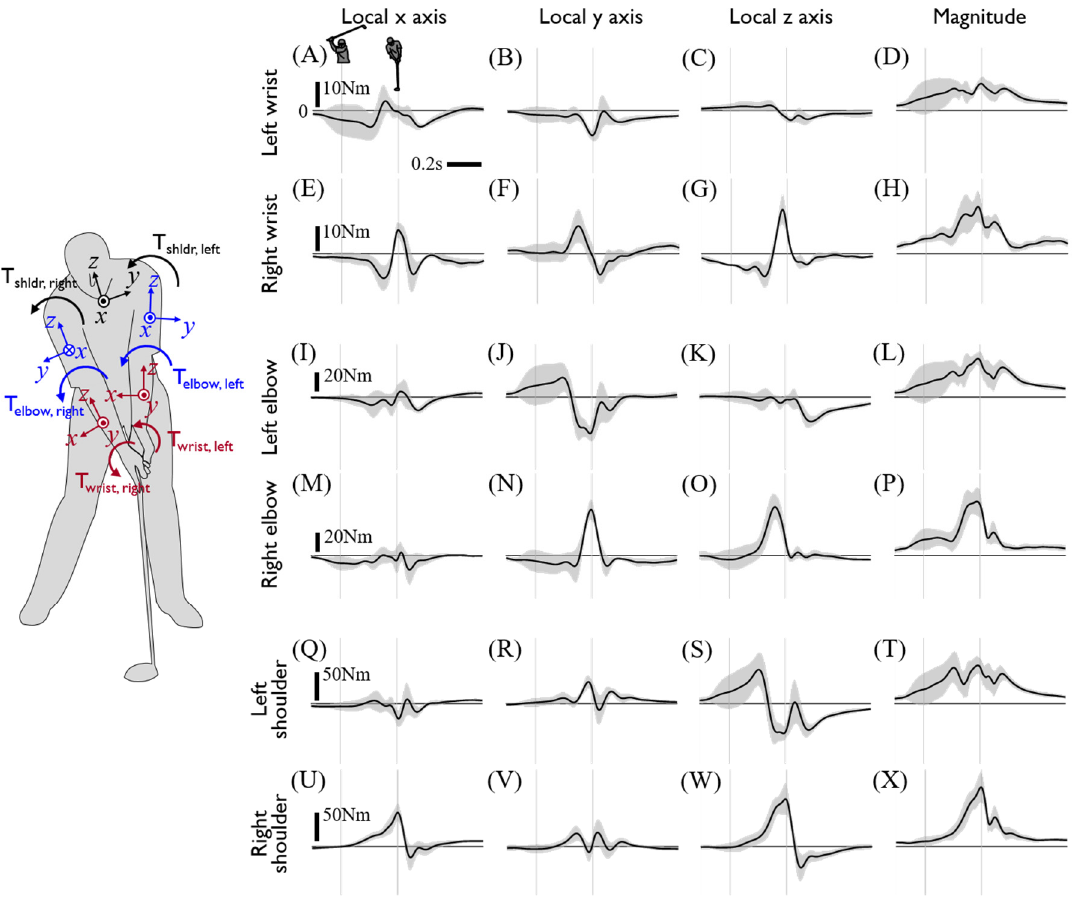
Figure 7. Calculated joint torques of the upper limbs. Each row shows the joint torque of the left wrist ( A – D ), right wrist ( E – H ), left elbow ( I – L ), right elbow ( M – P ), left shoulder ( Q – T ), and right shoulder ( U – X ), respectively. Each column shows the x, y, and z values and magnitude of joint torque at the local coordinate of the proximal segment. Torque acts on the distal segment of each joint and are the averages of driver swing data on all subjects. The two thin gray vertical lines indicate the backswing top and impact. The left silhouette shows the local coordinate of each segment at the address posture.